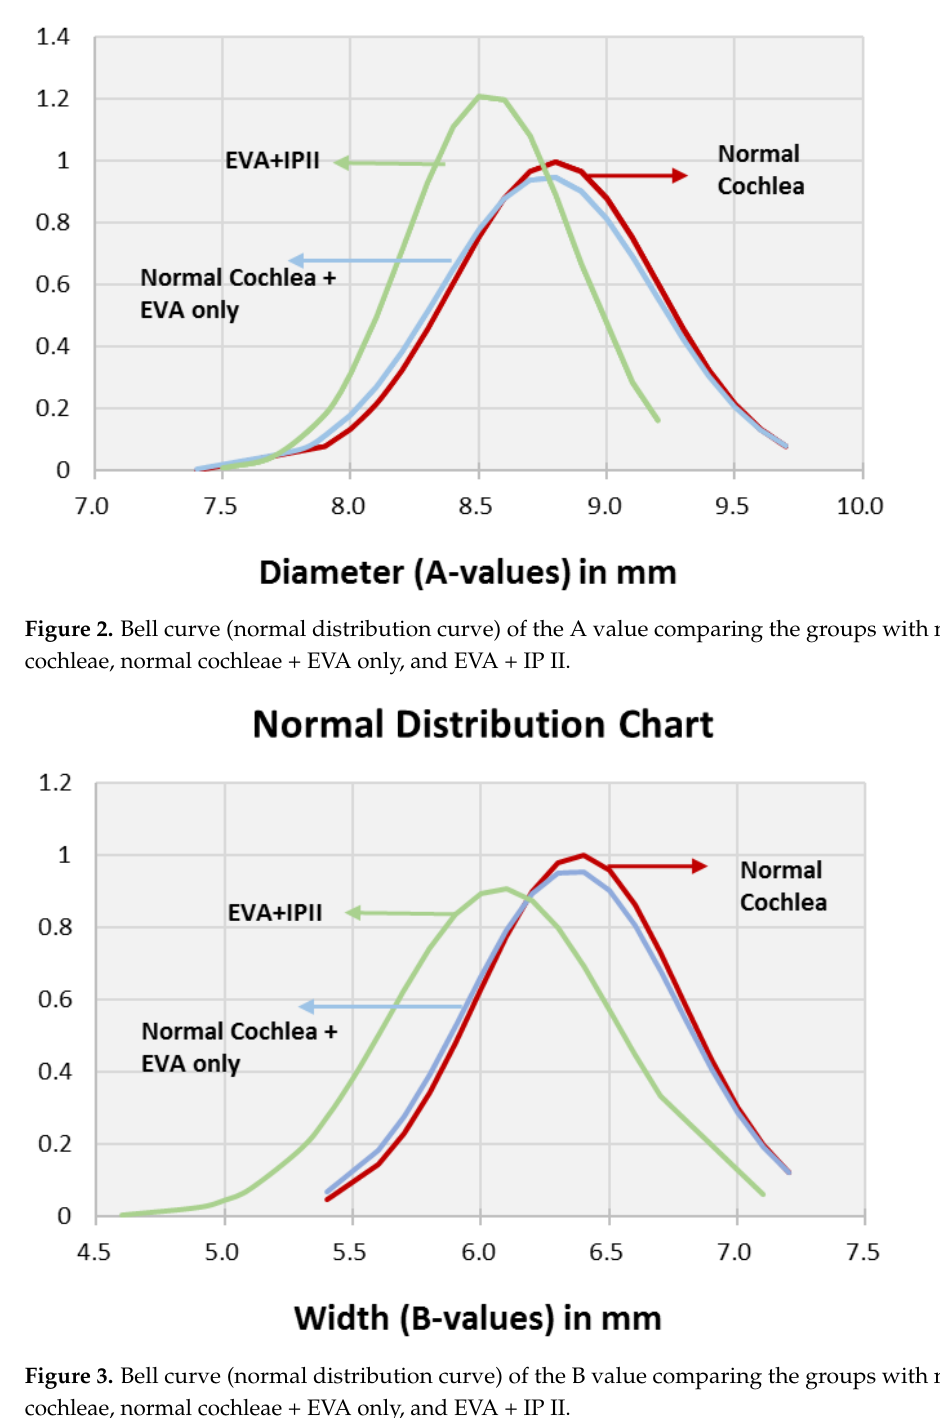
Figure 4. Bell curve (normal distribution curve) of the H value comparing the groups with normal cochleae, normal cochleae + EVA only, and EVA + IP II. In total, 37.6% (59/159) of the patent cochleae, 12.5% (2/16) of the EVA only group, and 9.46% (7/74) of the EVA + IP II group had an A value of ≥9.0 mm. No significant differences were found between the left and right ears in the three groups of patent cochleae, EVA only, and EVA with IP II (Table 2). Table 2. Comparison of the cochlear parameters between the left and right ear in the groups with patent cochleae, EVA only, and EVA + IP II.